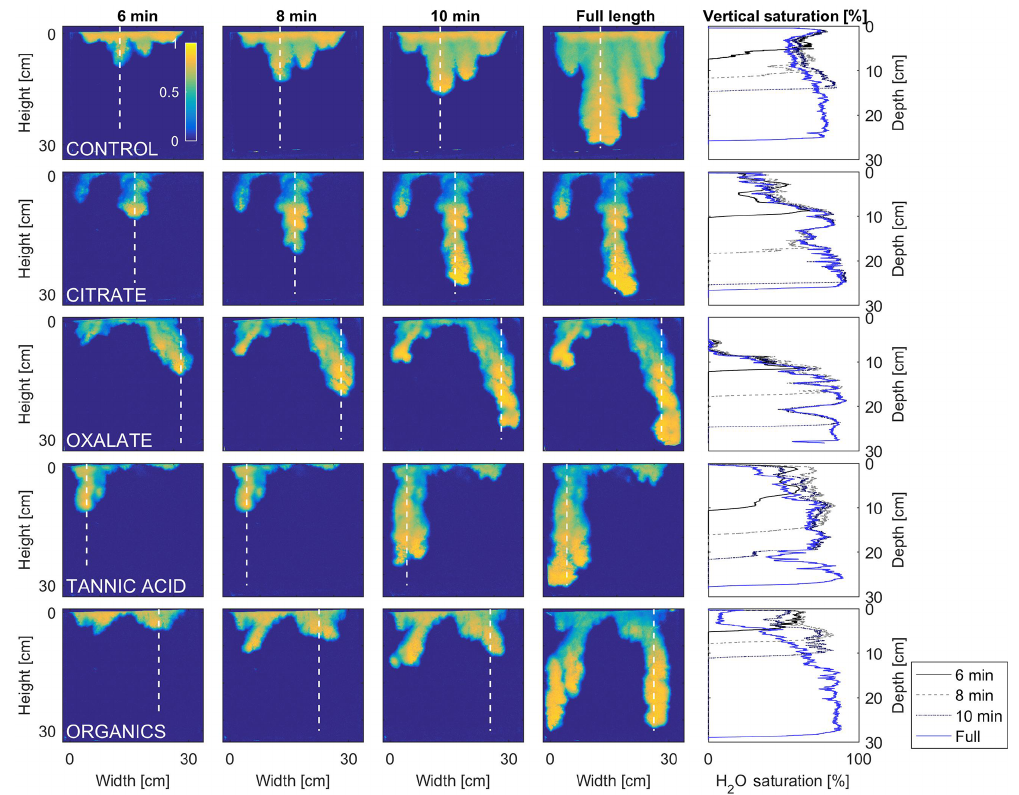
Figure A2. Second tank experiment data set. Multigraph comparison of the dynamic vertical profiles of infiltration of water in US Silica C778 ASTM graded sand for control (NaCl + HNS), and high concentrations of plant exudates (citrate and oxalate) and soil components (tannic acid and organics: Suwanee River natural organic matter, SRNOM). The images are of the main finger and the vertical water saturation profile analysis over